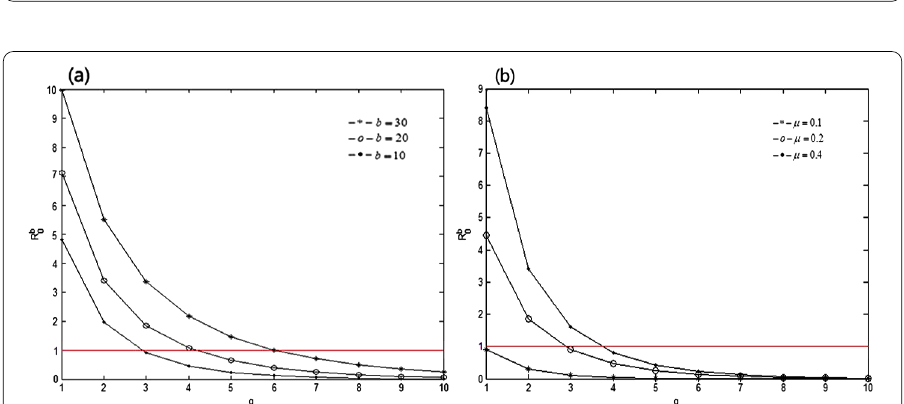
Figure 2 The bifurcation diagram of the parameter b ( p ) on the population x ( t ) in system (3.3) (system (3.4)); the other parameters δ = 0.6, d = 0.4, g = 0.05, h = 0.1, r = 0.8, μ = 0.4, q = 10, n = 6. ( a ) Ricker function; ( b ) Beverton–Holt function